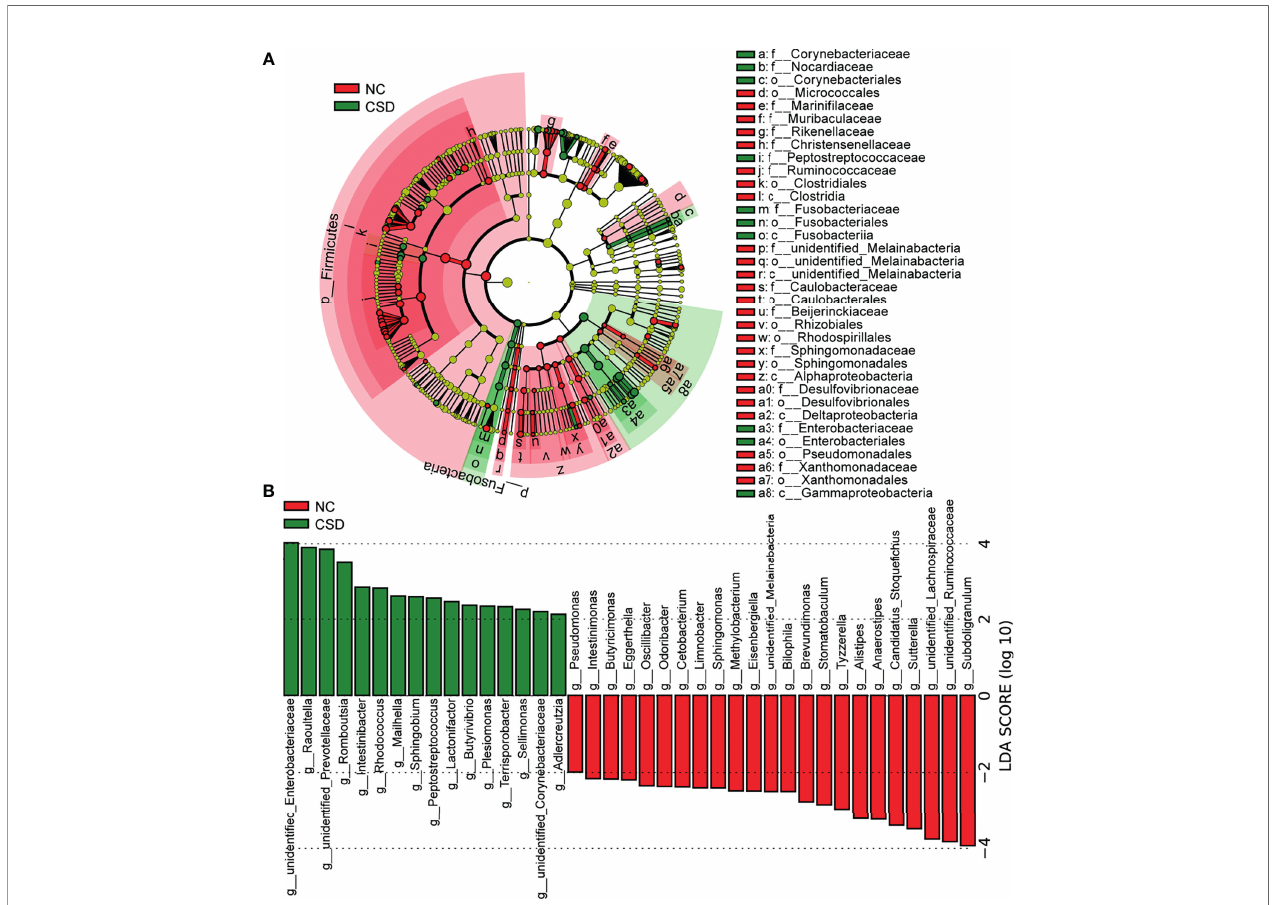
FIGURE 2 | Potential diagnostic markers obtained by linear discriminant analysis (LDA). (A) Taxon with a difference between the CSD group and NC group from the class to the genus level. Each small circle represents a different taxonomic level, and the diameter of the small circle is proportional to the relative abundance. Coloring principle: the species with no signi fi cant difference are colored yellow uniformly, and those with a signi fi cant difference are colored with the group. The red node indicates the microbial groups that play an important role in the NC group, and the green node indicates the microbial groups that play an important role in the CSD group. (B) Genus with a signi fi cant difference between the CSD group and NC group using the histogram of LDA distribution (p<0.05, LDA scores(log10)>2). NC, normal control; CSD, chronic spontaneous urticaria and symptomatic